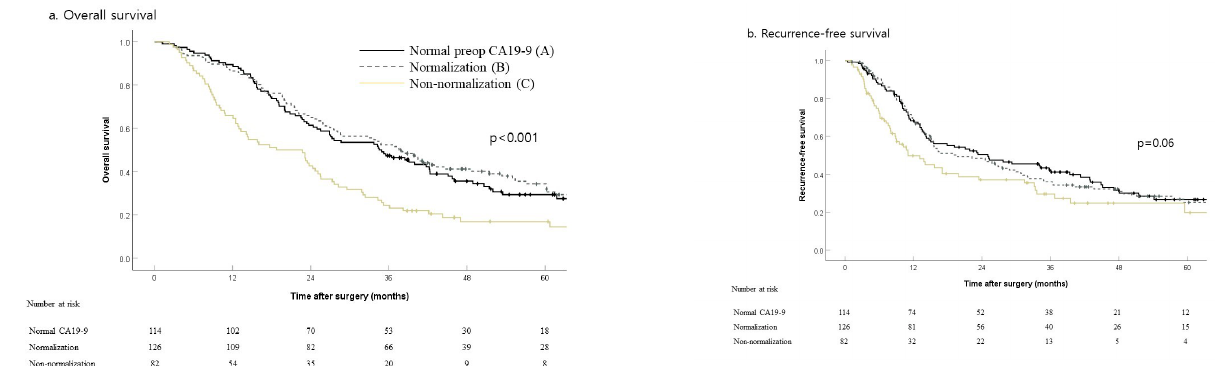
Figure 1. Long-term outcomes by perioperative carbohydrate 19-9 (CA19-9) status in 322 patients who underwent resection with curative intent of perihilar cholangiocarcinoma (A: preoperative normal CA19-9, B: high preoperative and normalized postoperative CA19-9, and C: high preoperative and non-normalized postoperative CA19-9): ( a ) overall survival, p = 0.475 (A vs. B), p = 0.001 (A vs. C), p < 0.001 (B vs. C) and ( b ) recurrence-free survival, p = 0.854 (A vs. B), p = 0.046 (A vs. C), p = 0.077 (B vs. C).